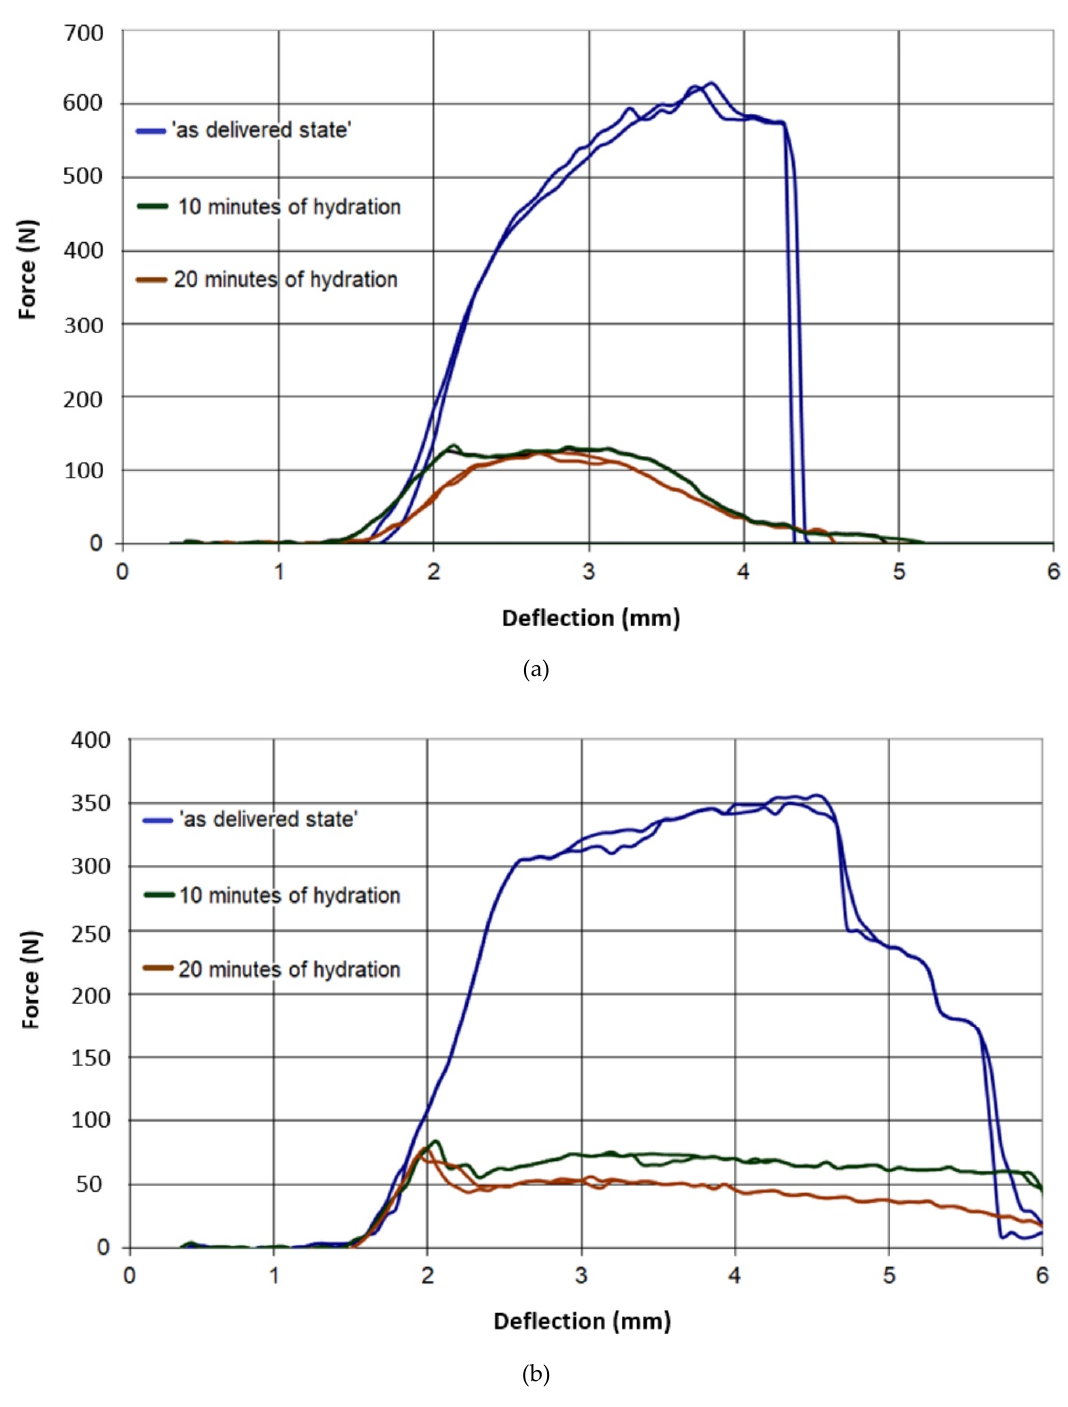
Figure 8. Force –deflection curves of the tested specimens of type B, ( a ) parallel to the sheet production direction, ( b ) perpendicular to sheet production direction.